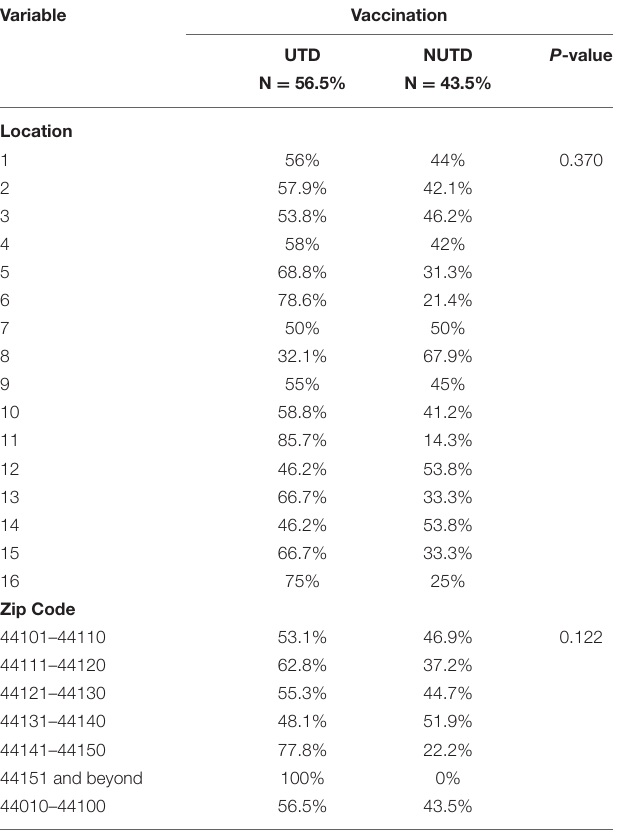
TABLE 2 | Bivariate analysis-categorical outcomes (vaccination